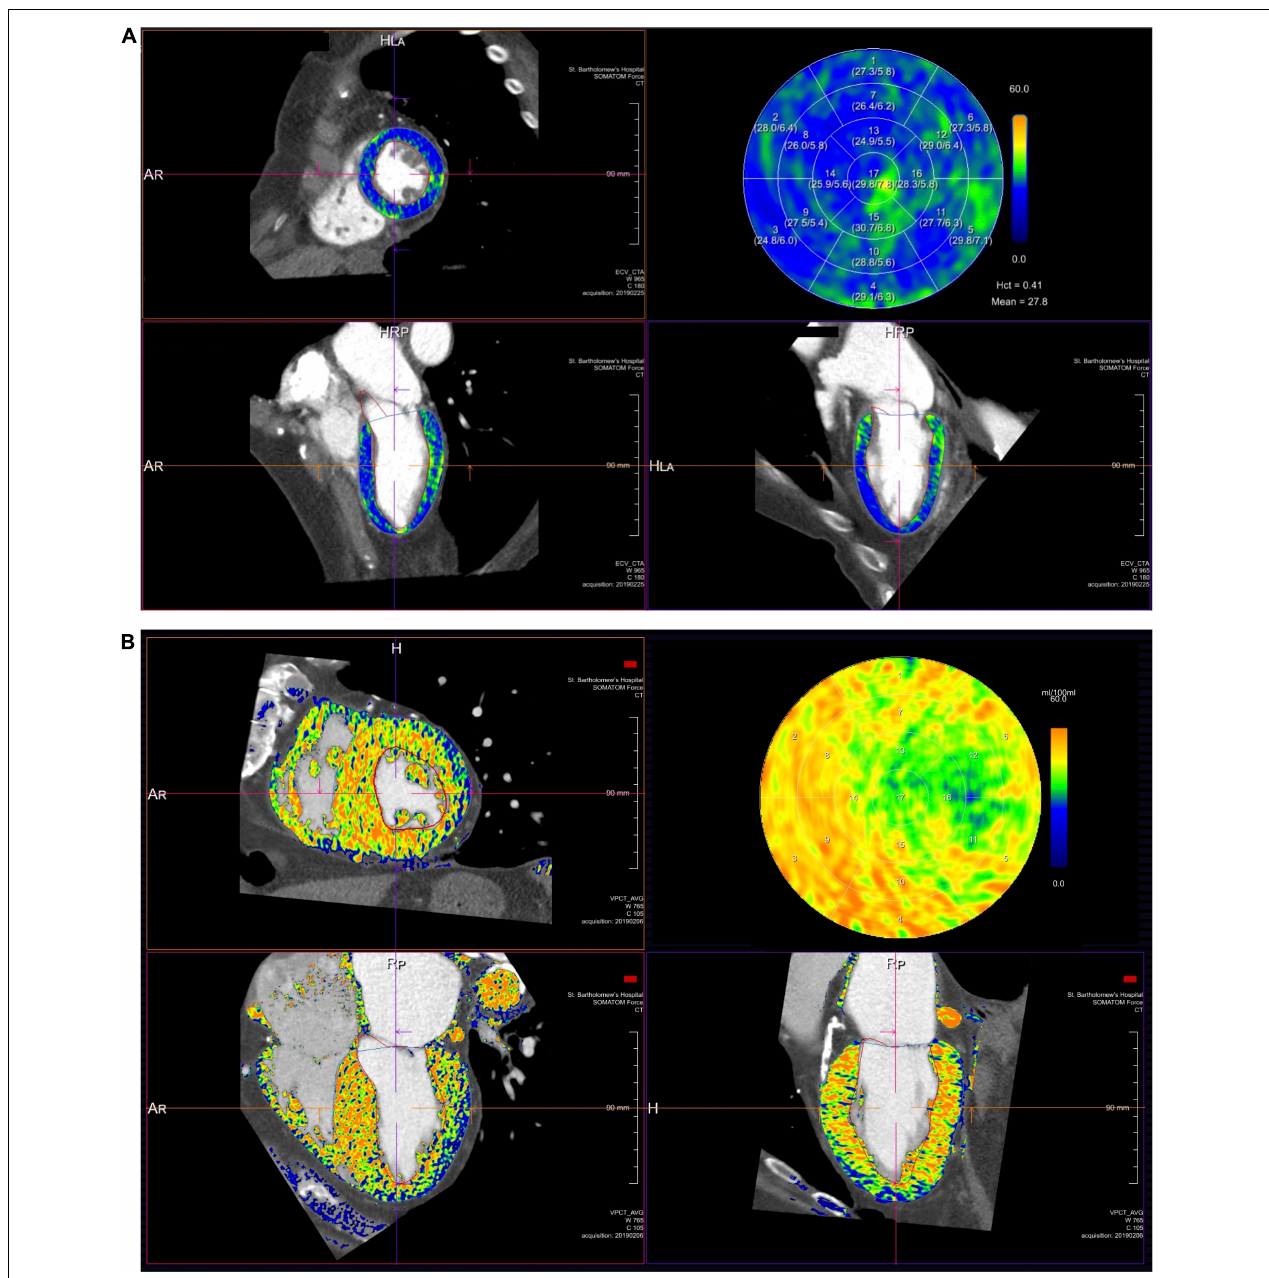
FIGURE 6 | Extracellular volume quantification in two patients: (A) severe AS and (B) severe AS and cardiac transthyretin amyloidosis. Each panel illustrates a short-axis, 4 and 2 chamber views and a bull’s eye plot. High extracellular volume seen in panel (B) is identified by the yellow/orange coloration compared to lower extracellular volume in panel (A) identified by the green/blue